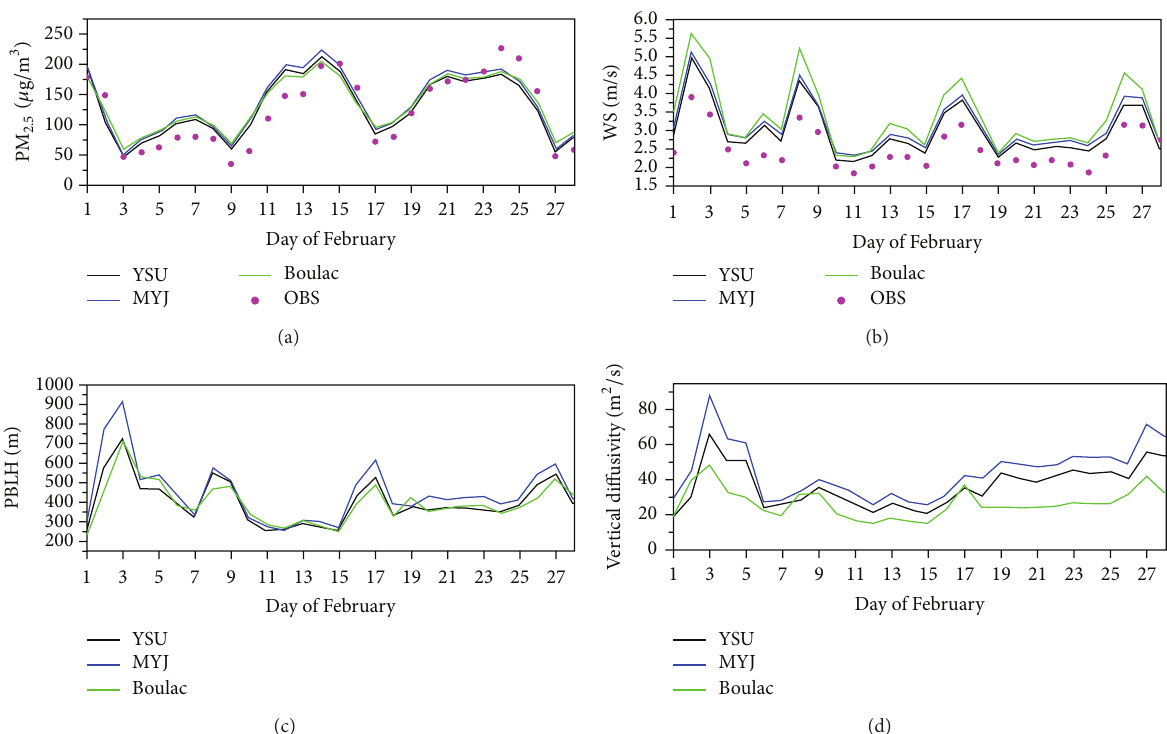
Figure 4: Variations of the daily averaged PM 2.5 concentration (a), wind speed near-surface (b), PBLH (c), and vertical diffusivity (d) of the area mean in